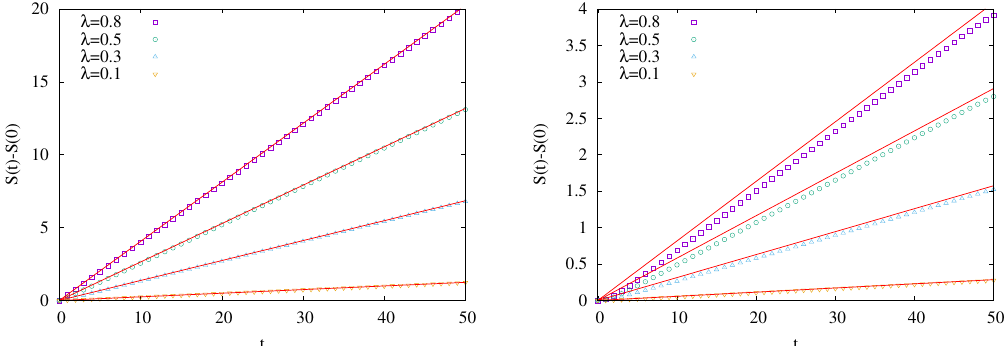
Figure 11: Entropy growth for the hopping defect after a global quench with µ → ∞ (left) and µ = 0.1 (right), for various λ and L = 50. The red solid lines show the quasiparticle ansatz with modified occupation function (66) given via the transmis- sion coefficient